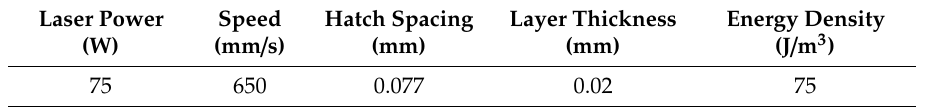
Table 3. Table showing optimized process parameters used to print test cubes and tensile test coupons.